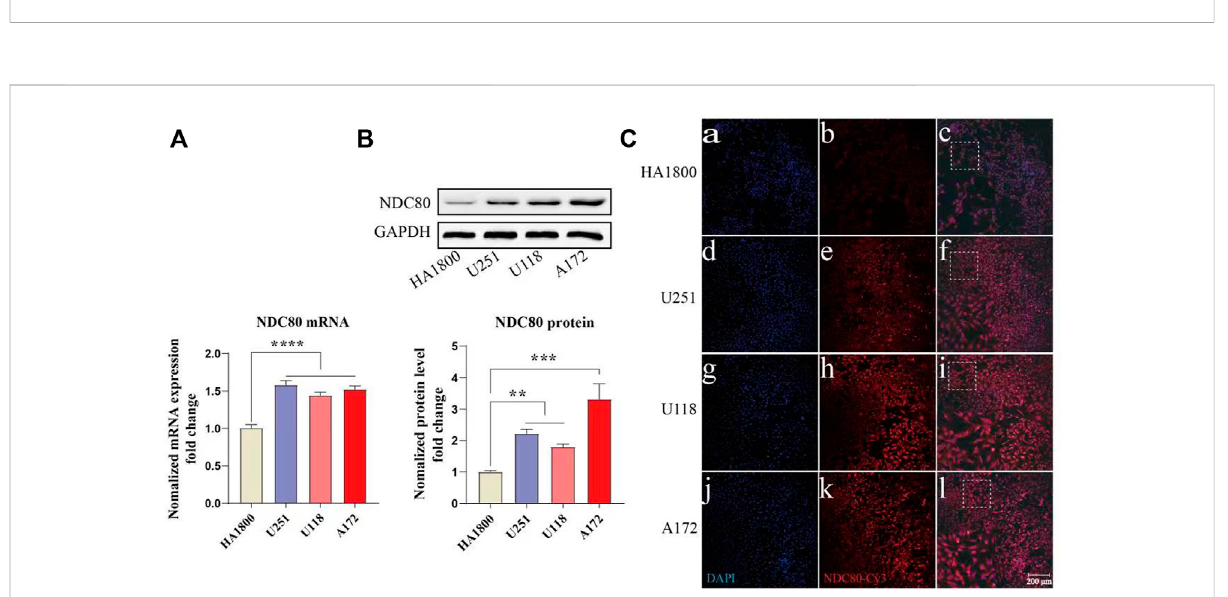
FIGURE 8 ExpressionofNDC80inhumanglioblastomacellsandnormalcells. (A) TranscriptionallevelsofNDC80inhumanglioblastomacellsandnormal cells. Statisticalanalysis was performedby usingone-way ANOVAwith Bonferroni ’ smultiplecomparison test; F 3,32 =28.59. n =3tests on 3samples per group. (B) Translational levels of NDC80 in human glioblastoma cells and normal cells. Statistical analysis was performed by using an unpaired t -test n = 3 samples per group. (C) Immuno fl uorescence of NDC80. (b) , (e) , (h) and (k) Cy3-immuno fl uorescence (red) indicates NDC80 was observed in cells. (a) , (d) , (g) and (j) DAPI (blue) indicates nuclear staining in cells. (c) , (f) , (i) and (l) merged image (magni fi cation × 100). Data are presented as mean ± SEM. ** p < 0.01, *** p < 0.001, and **** p <